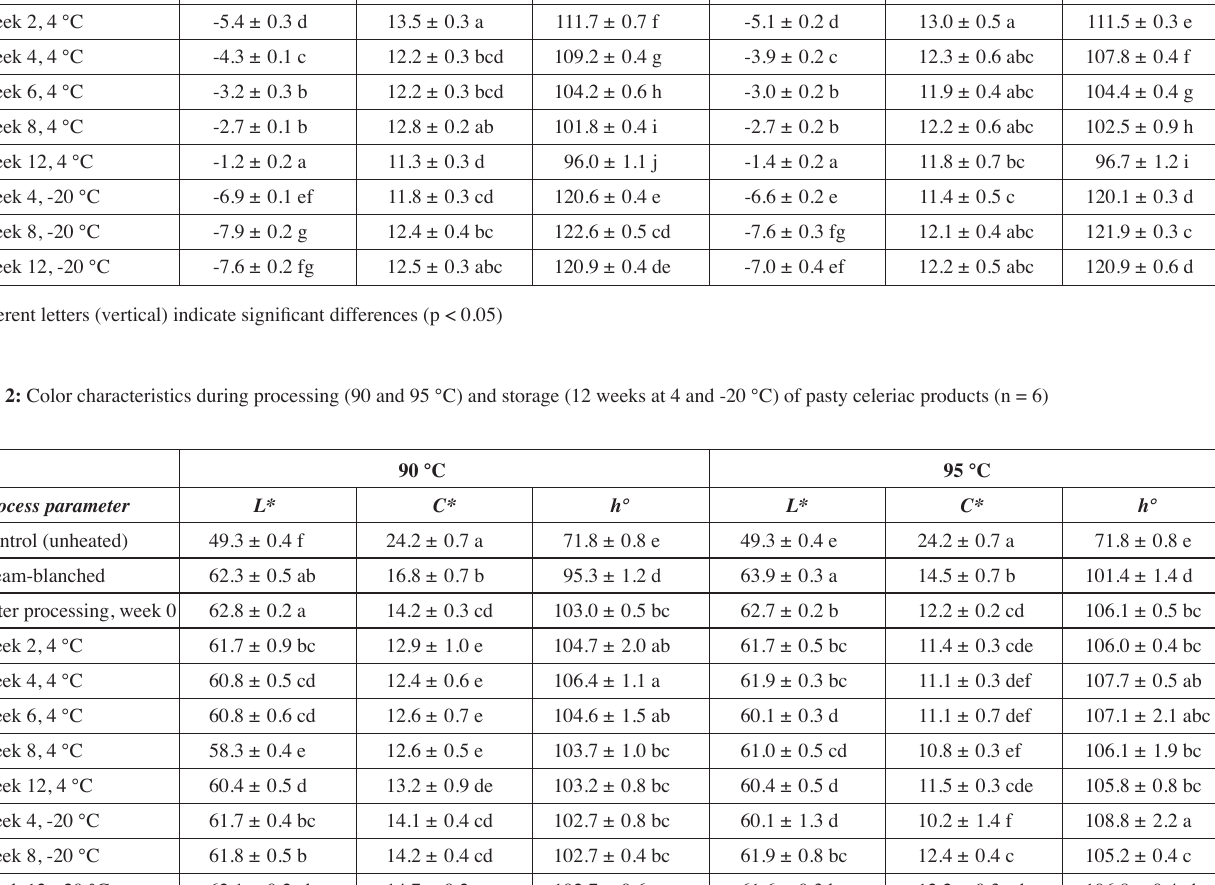
Tab. 1: Color characteristics during processing (90 and 95 °C) and storage (12 weeks at 4 and -20 °C) of pasty parsley products (n =